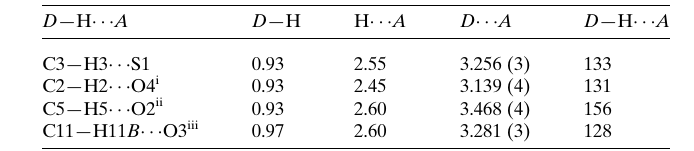
Table 1 Hydrogen-bond geometry (A˚ , (cid:2) ).